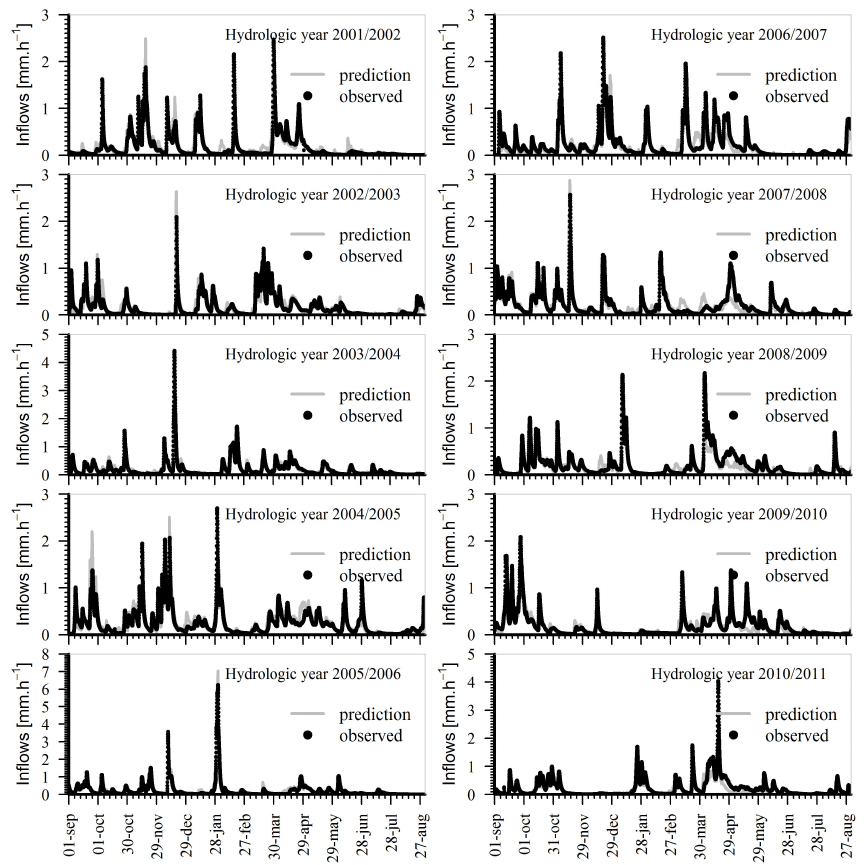
Figure 2. Observed and predicted reservoir inflow hydrographs during calibration (left-column panels) and validation (right-column panels) of the conceptual